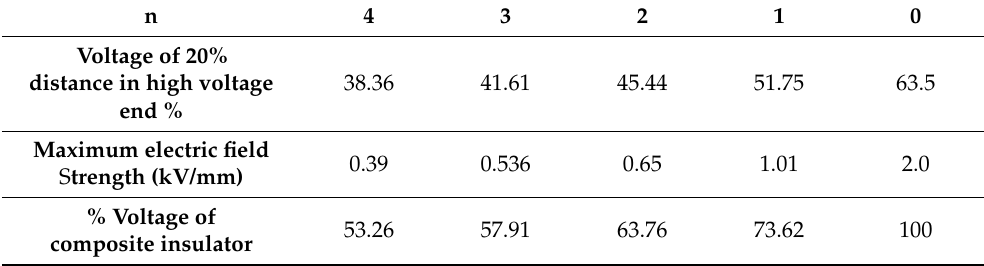
Table 4. Insulator’s electric field strength reduction when different glass insulators are installed.